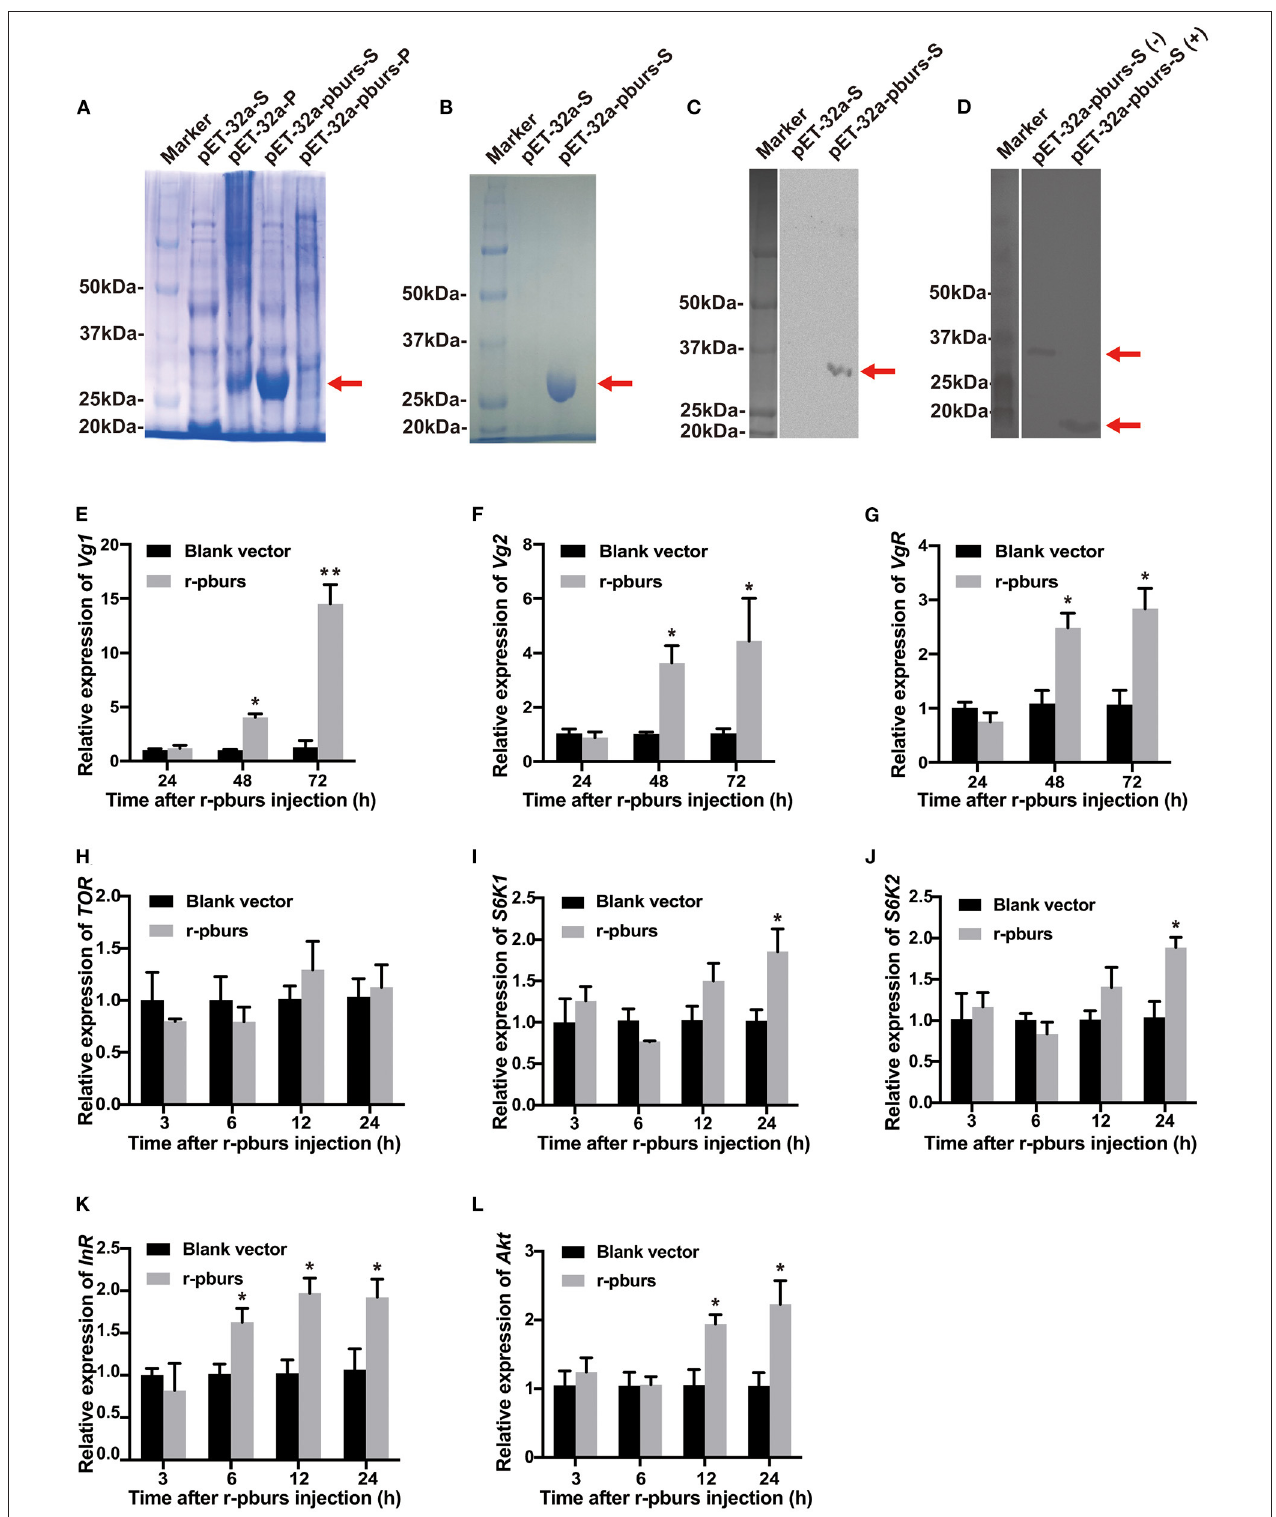
FIGURE 7 | Effects of recombinant pburs (r-pburs) protein injection on the expression of Vg and IIS/TOR pathway genes. (A) Coomassie Blue staining of recombinant protein separated by sodium dodecyl sulfate-polyacrylamide gel electrophoresis (SDS-PAGE). Marker: the protein molecular weight (MW) marker; pET-32a-S: